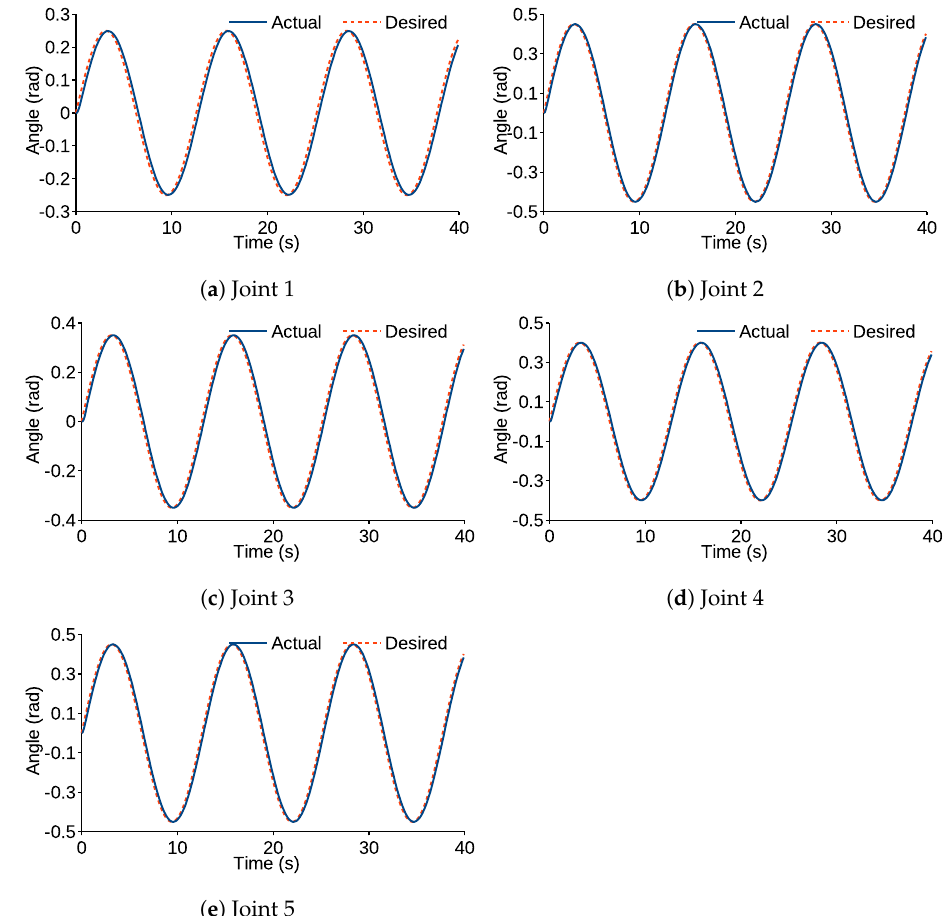
Figure 7. Validation of LAC for robotic model in virtual environment in RoM condition.